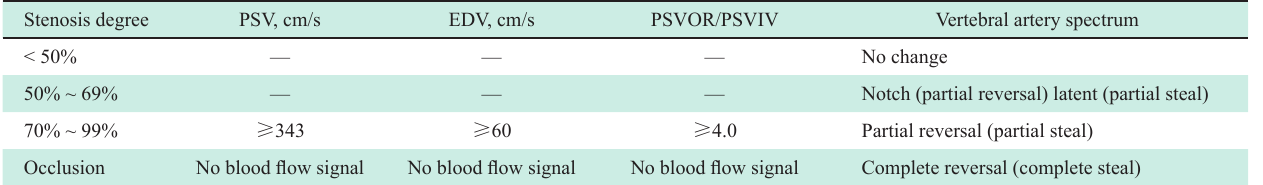
Table 4 Diagnostic criteria for subclavian artery stenosis (2011, Xuanwu Hospital, Capital Medical University) Stenosis degree PSV, cm/s EDV, cm/s PSVOR/PSVIV Vertebral artery